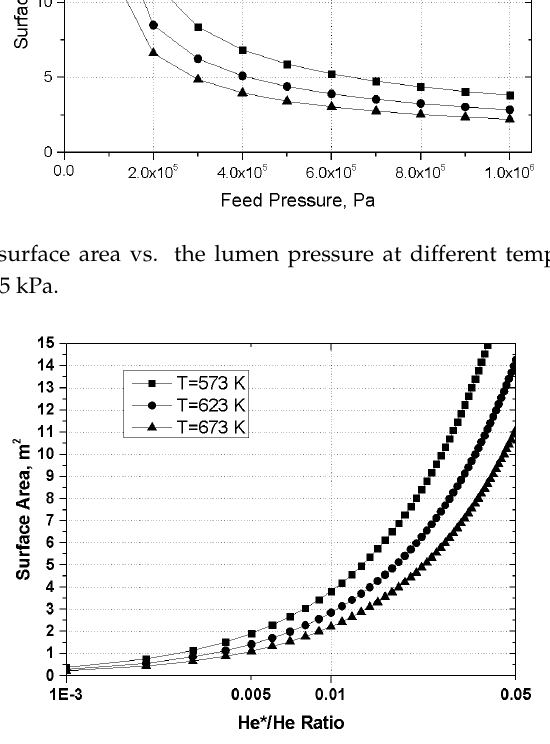
Figure 4. Membrane area required vs. the He/T feed ratio at different temperatures and 1 MPa of lumen pressure and 5 kPa of shell pressure.